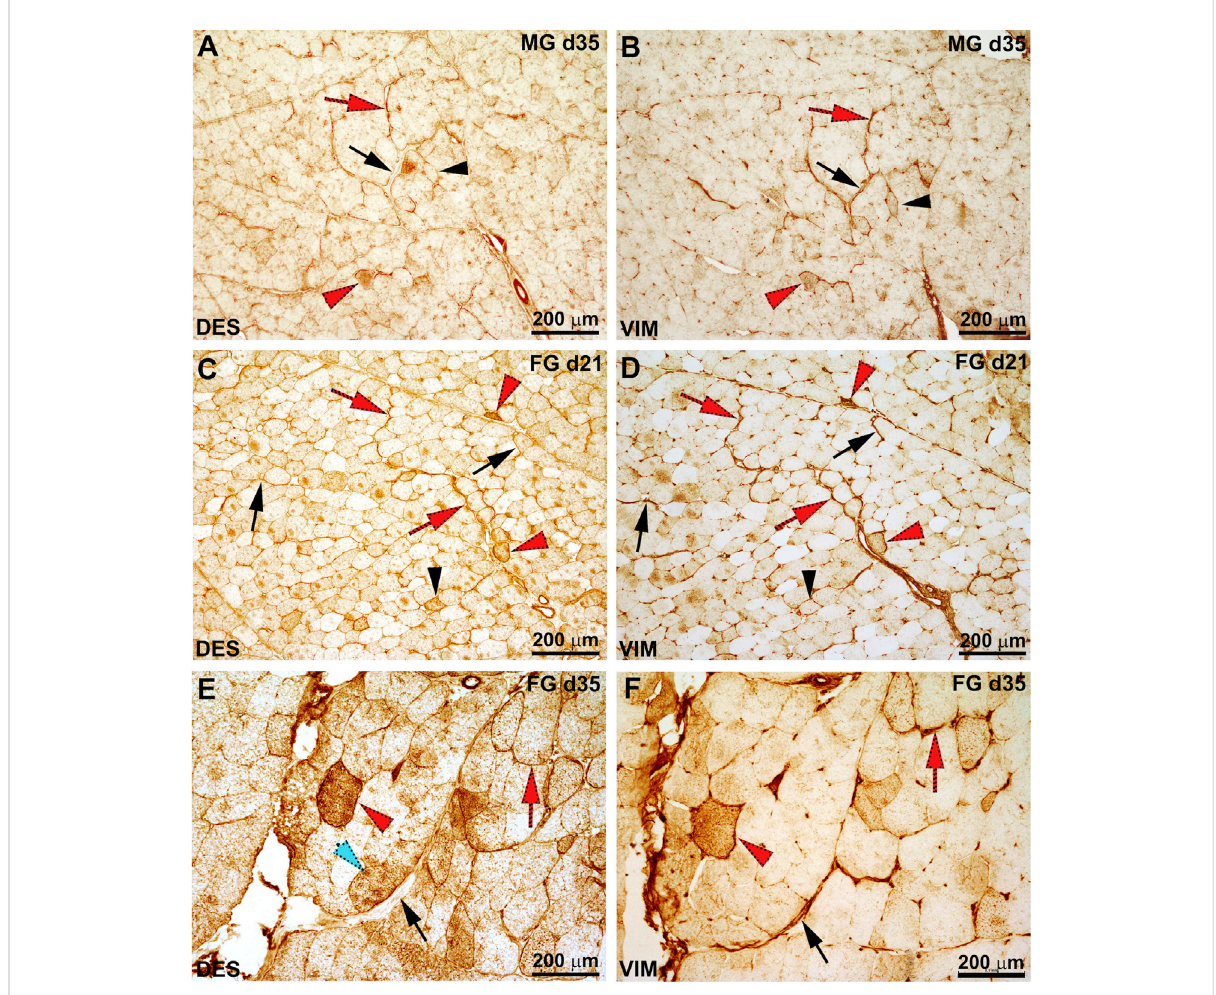
FIGURE 2 Representativeimagesoftheserialsectionsfordesmin(DES)andvimentin(VIM)immunoreactivityinthemedium-growing(MG) (A,B) andfast- growing(FG) (C – F) chickensat21and35 daysofage.Theperimysialconnectiveshowedpositivityagainsteachtargetprotein,whileinotherareasof thesectionsimmunoreactivityagainstoneproteinratherthattheotherwasevident.Indetail,sometractsoftheperimysialconnectivewerefoundto co-expressDESandVIM(redarrow)whileinothersonlyimmunoreactivityforVIMwasobserved(blackarrow).Similarly,some fi berswerefound to colocalize DES and VIM (red arrowhead) while others exhibit positivity only for VIM or DES (black